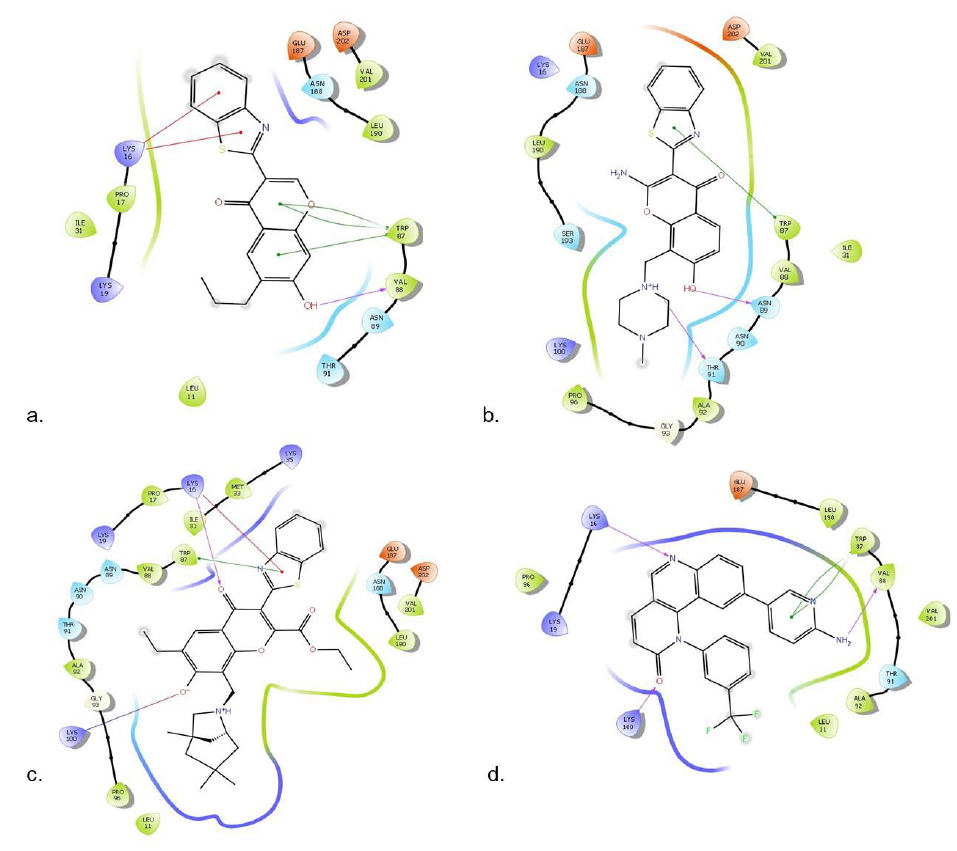
Figure 9. Ligand interaction diagrams for the compounds ( a ) 2c , ( b ) 7h , ( c ) 7l and ( d ) Torin2.